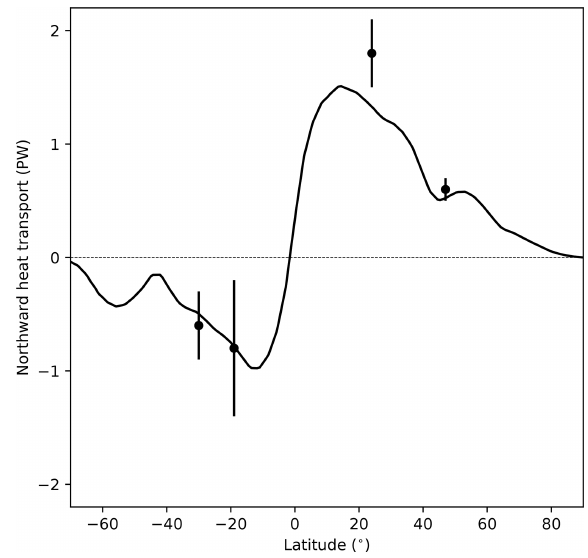
Figure 18. Northward heat transport in the global ocean in CanESM5 (in petawatts), with error bars showing the inverse es- timate of Ganachaud and Wunsch